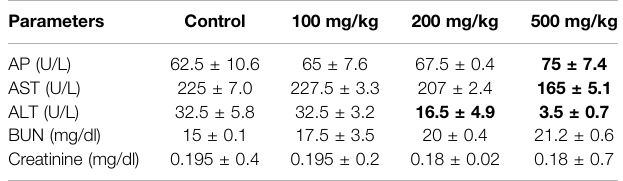
TABLE 3 | The hematological parameters of mice after 4 weeks of treatment with distinct doses of the aqueous extract of A. vasica. Parameters Control